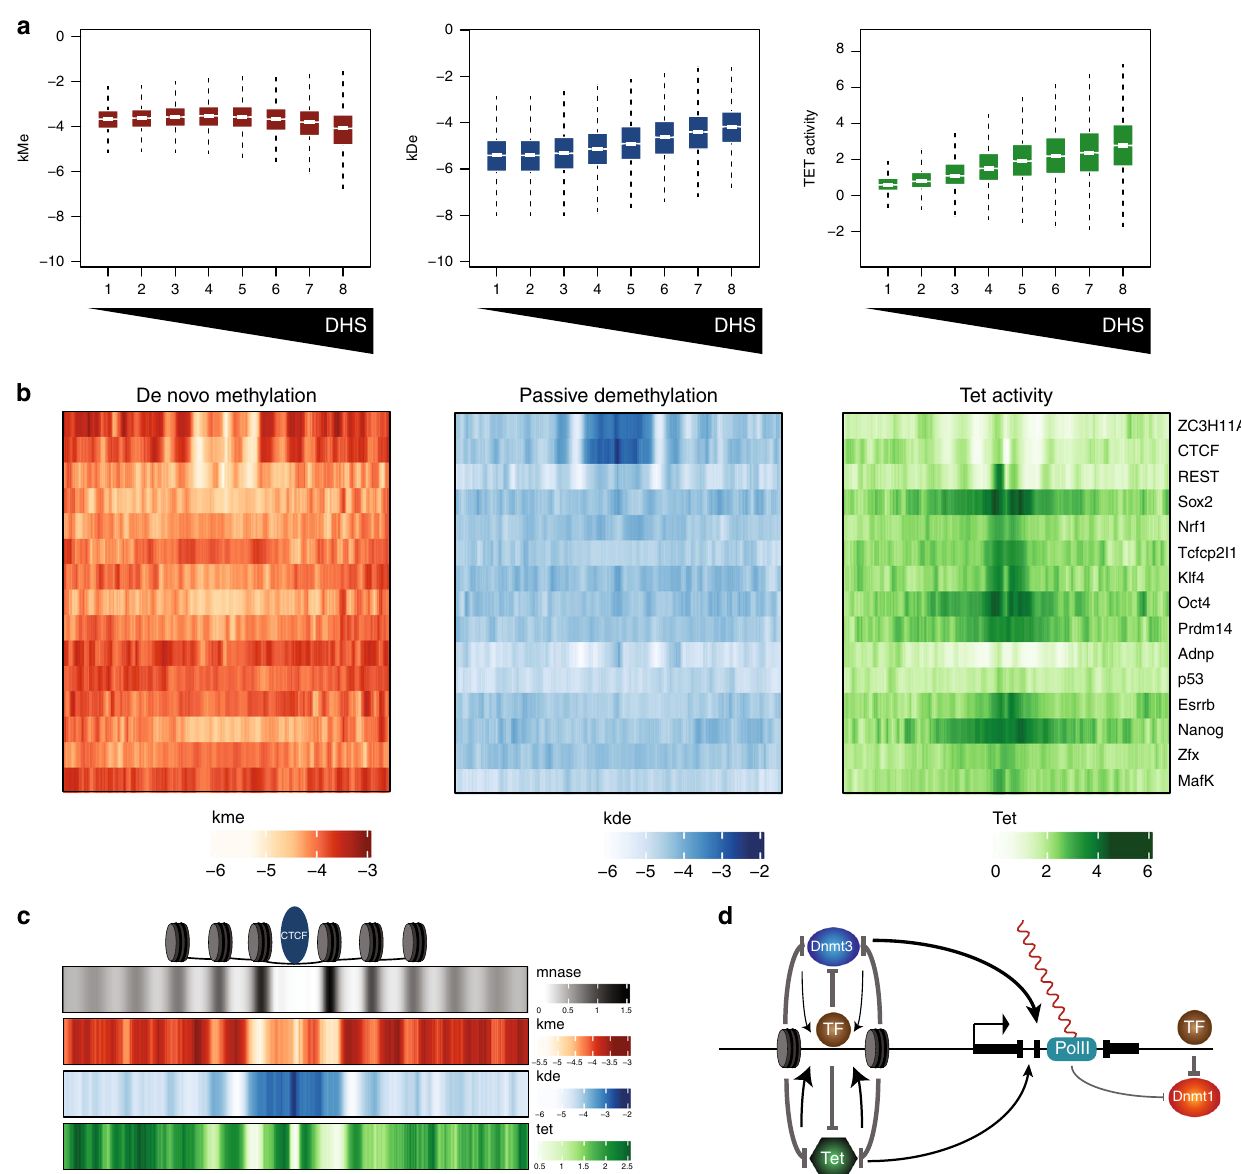
Fig. 6 Transcription factor binding shows variable effects on methylation and demethylation activity. a Rates and TET activity as a function of distal DHS signal. The mouse genome was split into 500 bp bins, and reads tallied for all bins that were completely mappable. Bins were then selected as having a minimum distance of 10 kb from an annotated promoter, and split based on number of DHS reads overlapping these bins. DHS signal increases with increasing bin number, where it is apparent that while k me (left) decreases with increasing accessibility, both k de (middle) and TET activity (right) increase. Boxplot elements are as de fi ned in Fig. 4d. b Rates and TET activity as a function of distance to bound TF motifs. ENCODE ChIP data for 15 TFs was quanti fi ed by counting reads surrounding motifs for each TF in a 201 bp window centered on the motif. Each row of the heatmap represents mean rates as a function of distance to the center of the motif for the respective factor. Sites represented here were selected as the top 900 enriched motif occurrences for each factor (see “ Methods ” for enrichment determination). c Nucleosome positioning, rate of de novo methylation, passive demethylation, and TET activity around bound CTCF sites, color as in b . MNase read counts were shifted by 75 bp to re fl ect position of the nucleosome dyad. d Model representing the effect of chromatin processes on methylation and demethylation rates. Presence of bound transcription factors can inhibit both processes, while transcription through gene bodies results in increased de novo methylation and passive demethylation. TET proteins in contrast tend to illicit the strongest effect on demethylation rates at accessible regions proximal to bound transcription